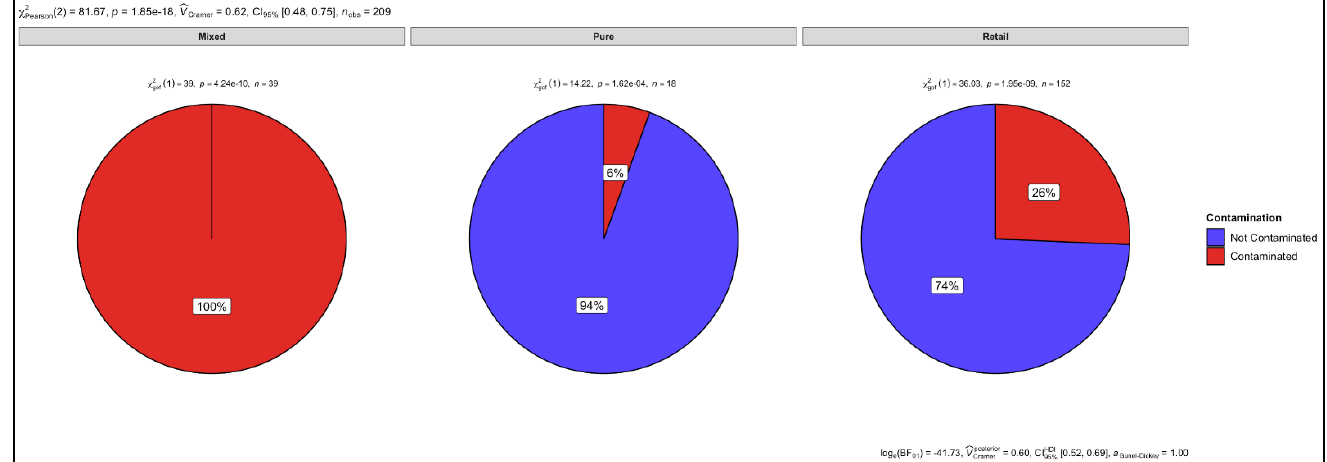
Figure 12. Proportional test for mixed, pure, and retail samples. The retail samples were then statistically analysed, according to the different meat types. There was no contamination observed in the biltong samples that had not specified which species they were from and the p -value ( p = 0.001) shows that there was no statistically significant level of contamination (Figure 13). There was contamination observed in the mince (15%), patties (13%), and sausage (38%) samples that had not specified which species they were from. The p -values for the mince ( p = 2.56 × 10 − 4 ) and patty ( p = 0.005) samples indicate that there was a statistically significant level of contamination, however, there was no statistically significant level of contamination in the sausage ( p = 0.275) samples (Figure 13).